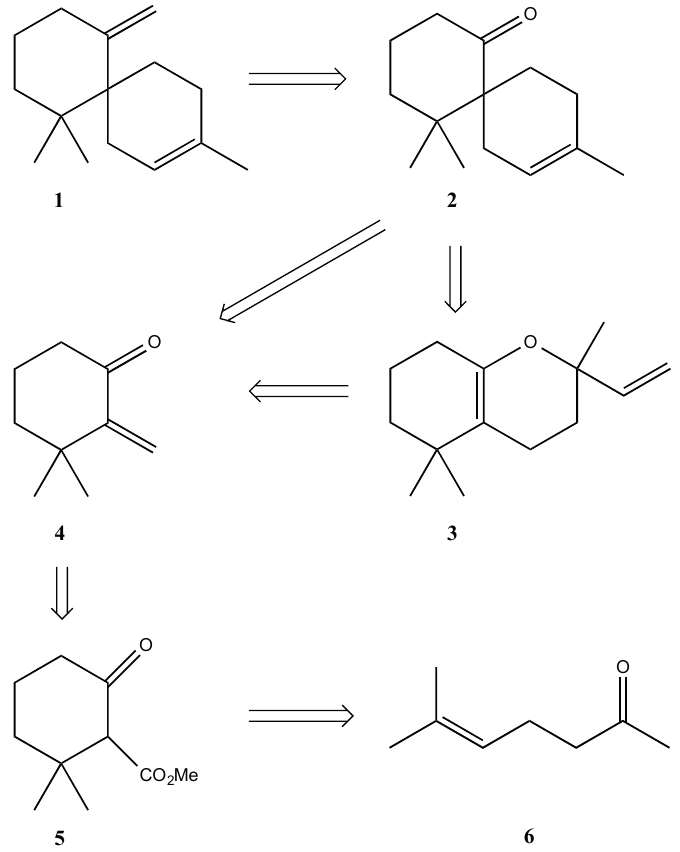
Scheme 1. Retrosynthetic analysis of the target molecule 1